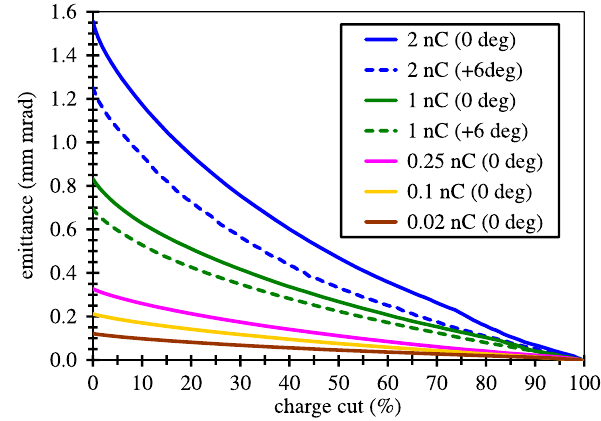
FIG. 27. Measured core xy emittance for different charges as a function of the charge cut. A charge cut of 0% corresponds to the emittance values from the raw phase space with full beam signal taken into account. The corresponding gun phase w.r.t. the MMMG phase as used during the measurements is shown in the